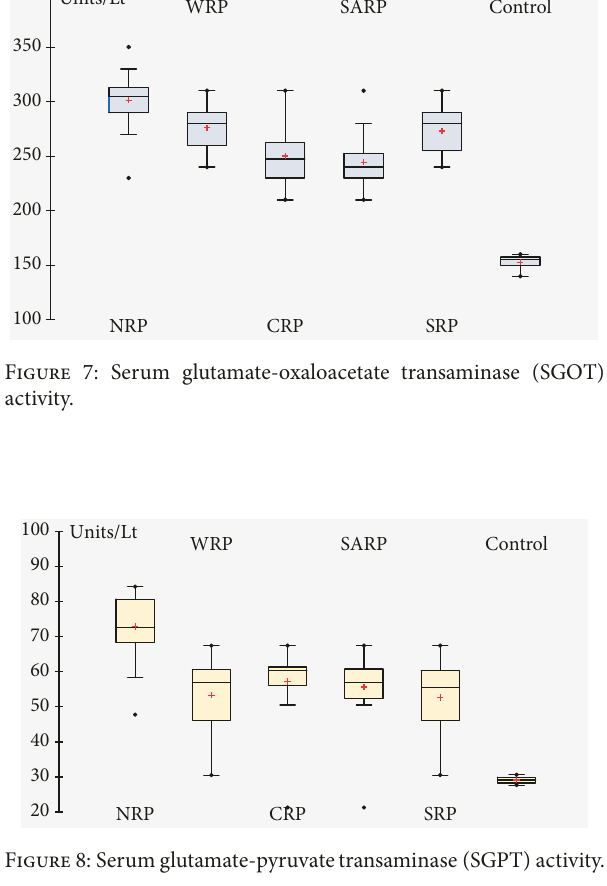
relationship between effects of envenomation with the time of envenomation [52] current study also found severity of the venom increasing parallel to the time.